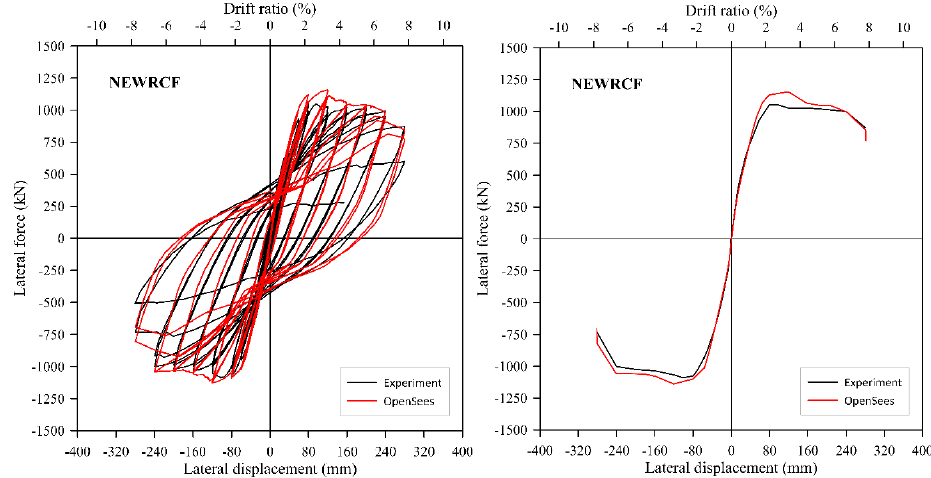
Figure 19. Comparison of the experimental and simulation results for NEWRCF.